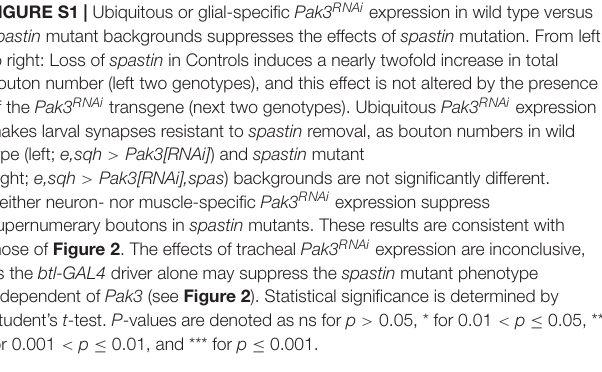
FIGURE S1 | Ubiquitous or glial-specific Pak3 RNAi expression in wild type versus spastin mutant backgrounds suppresses the effects of spastin mutation. From left to right: Loss of spastin in Controls induces a nearly twofold increase in total bouton number (left two genotypes), and this effect is not altered by the presence of the Pak3 RNAi transgene (next two genotypes). Ubiquitous Pak3 RNAi expression makes larval synapses resistant to spastin removal, as bouton numbers in wild type (left; e,sqh > Pak3[RNAi] ) and spastin mutant (right; e,sqh > Pak3[RNAi],spas ) backgrounds are not significantly different. Neither neuron- nor muscle-specific Pak3 RNAi expression suppress supernumerary boutons in spastin mutants. These results are consistent with those of Figure 2 . The effects of tracheal Pak3 RNAi expression are inconclusive, as the btl-GAL4 driver alone may suppress the spastin mutant phenotype independent of Pak3 (see Figure 2 ). Statistical significance is determined by Student’s t -test. P -values are denoted as ns for p > 0.05, * for 0.01 < p ≤ 0.05, ** for 0.001 < p ≤ 0.01, and *** for p ≤ 0.001. FIGURE S2 | Expression of two different Pak3 RNAi transgenes, and use of a different pan-neuronal driver, independently support alleviation the spastin mutant phenotype by glial, and not neuronal, Pak3 knockdown. Simultaneous pan-neuronal expression of the Pak3 GL 0028 and Pak3 v 39844 RNAi transgenes (“ Pak3[2xRNAi] ”) does not alleviate supernumerary boutons of spastin mutants ( p = 0.32 compared to paired control). The neuronal driver used in these experiments is elav C 155 -GAL4 rather than nsyb-GAL4 ; Dcr2 was also expressed to increase RNAi efficacy. In contrast, pan-glial expression of these Pak3 RNAi transgenes has the same effect as Pak3 NIG . 14895 R − 2 RNAi expression (from Figure 2 and Supplementary Figure S1 ), reducing terminal bouton number in spastin mutants to wild type levels ( p = 1.3 × 10 − 3 ; Student’s t